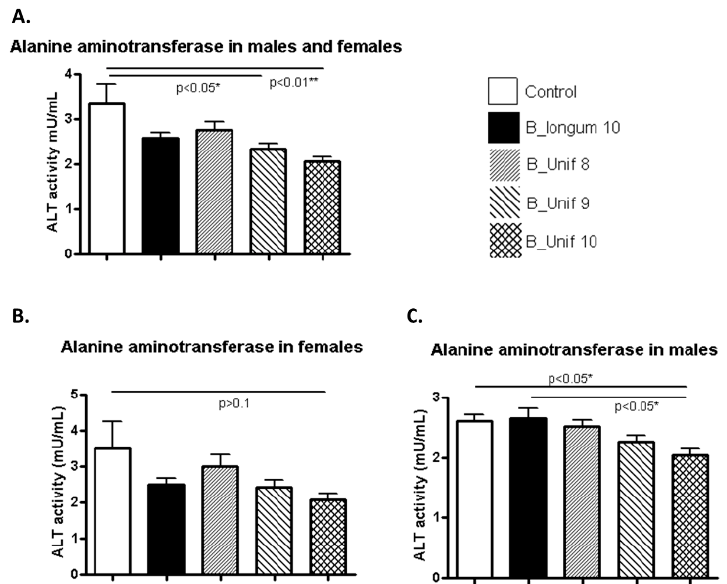
Figure 2. Alanine aminotransferase (ALT) activity measured in the serum of the experimental groups. ( A ) ALT activity (mU / mL) at the end of the study for all groups (50 animals, n = 10 per group). ( B ) ALT activity (mU / mL) at the end of the study for females in all groups (25 animals, n = 5 per group). ( C ) ALT activity(mU / mL)attheendofthestudyformalesinallgroups(25animals, n = 5pergroup). Measurements were made in duplicate. Statistical significance was considered when p < 0.050. * p ≤ 0.05, ** p ≤